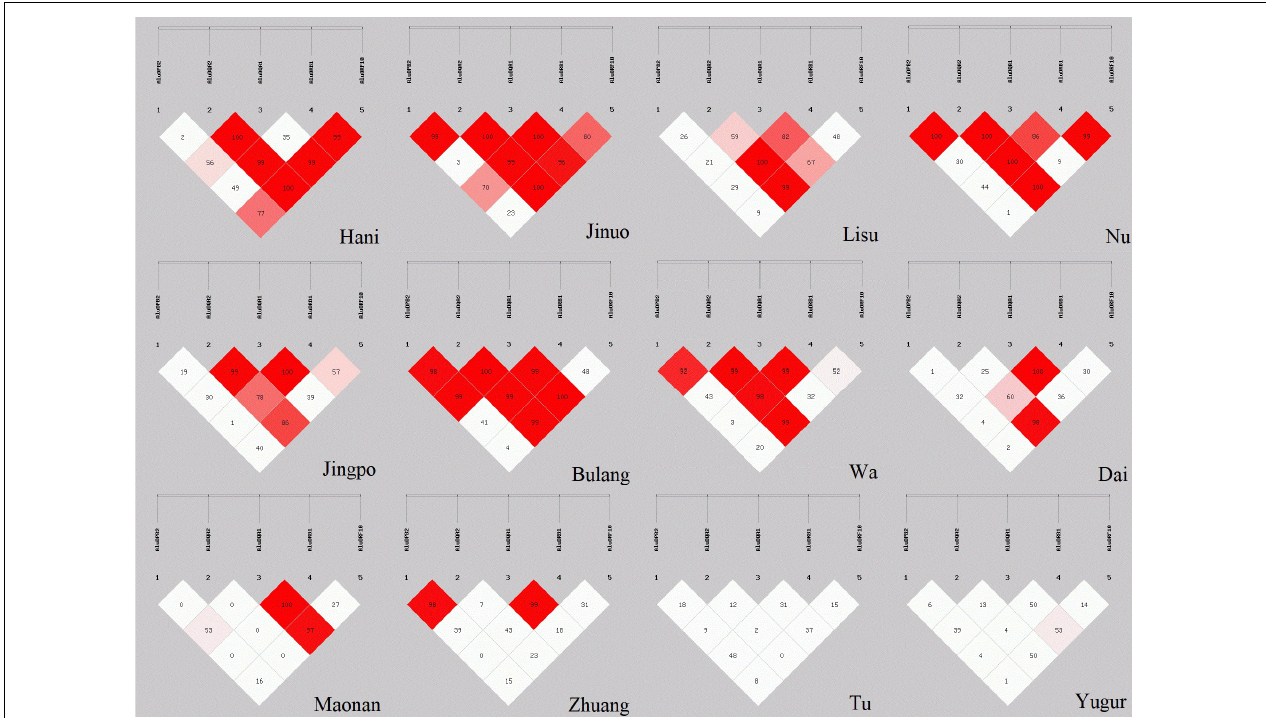
FIGURE 2 | LD estimations (D (cid:48) ) among five POALINs within MHC II region for 12 Chinese ethnic populations.